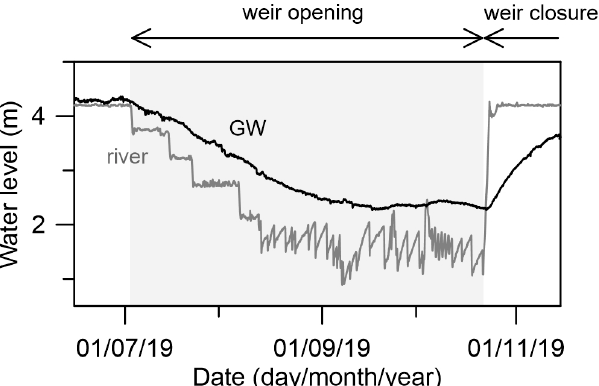
Figure 2. Variation of the groundwater level (GW) in observational well (OW1) due to the change in river level.